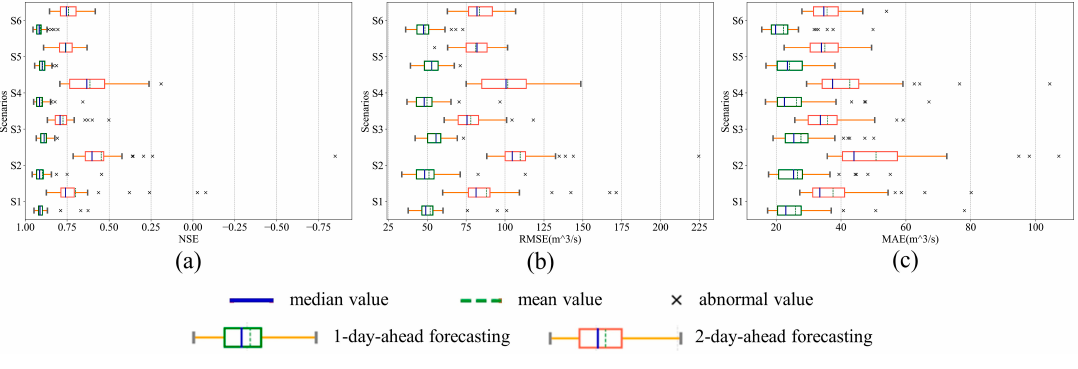
Figure 7. Box plots of the distribution of evaluation metrics in the validation stage. ( a ) Box plot of the distribution of NSE ; ( b ) box plot of the distribution of RMSE ; ( c ) box plot of the distribution of MAE.